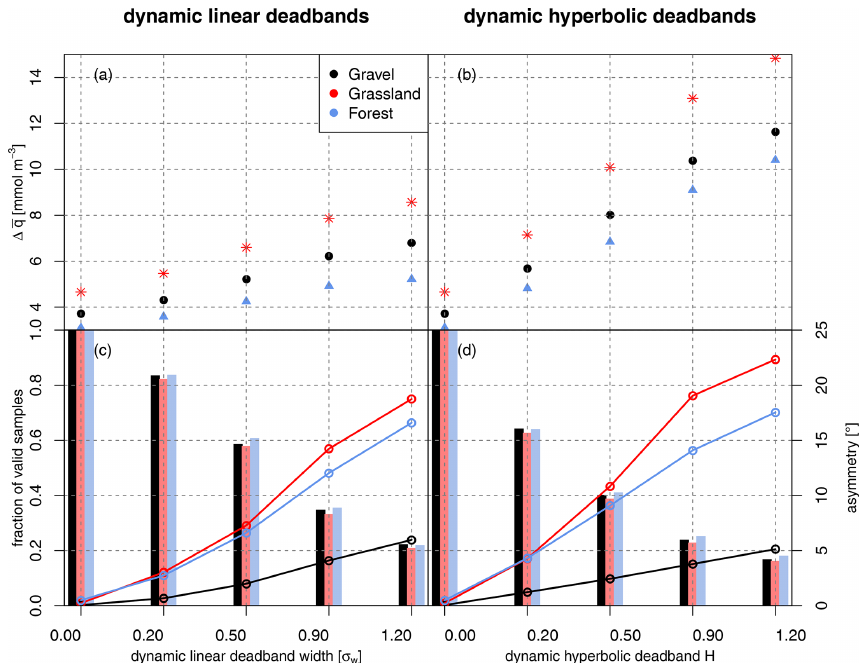
Figure 4. Effect of deadband size on the concentration difference and measures of the random error. Panels (a) and (b) show the concentration difference between up- and downdraft reservoir as a function of deadband size (linear deadbands in panel a and hyperbolic deadbands in panel b ). (c, d) The bars show the fraction of samples used for flux computation, and the overdrawn circles show the asymmetry between up- and downdraft vectors in the quadrant plot. The asymmetry is calculated as the absolute deviation in the angle between a straight line and a bent line constructed using the center points of up- and downdrafts and the origin in the quadrant plots. See Fig. 1 and accompanying text for